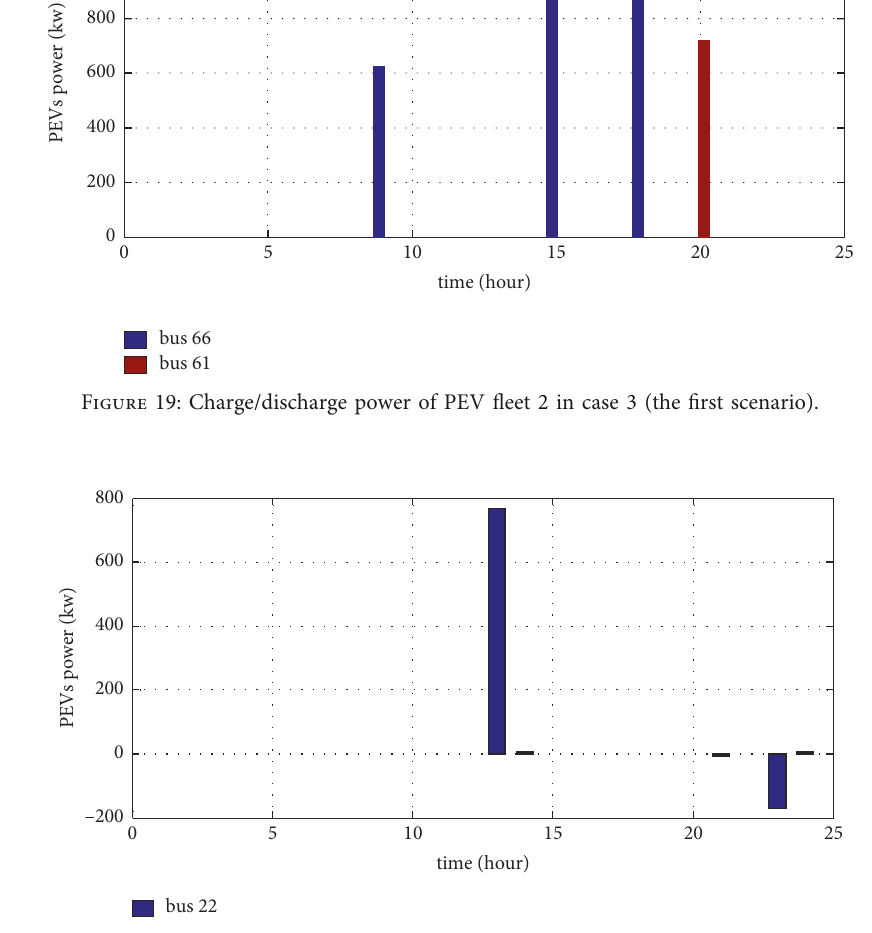
Figure 20: Charge/discharge power of PEV fleet 3 in case 3 (the first